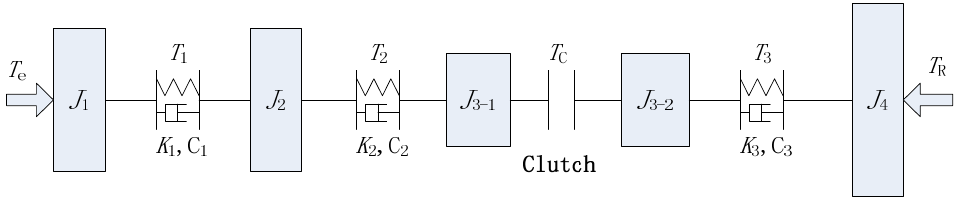
Figure 7. The simplified model of the powertrain system.